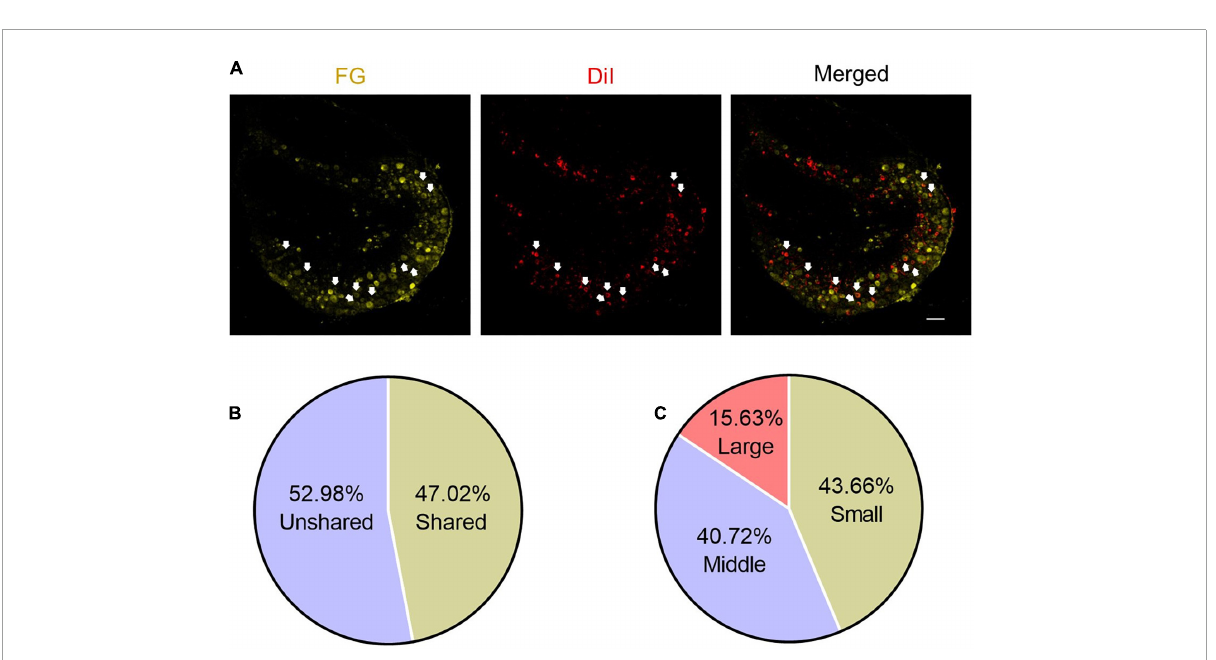
FIGURE2 Some DRG neurons innervate both ST36 acupoint and ipsilateral hind paw plantar. (A) The representative pictures of shared DRG neurons. FG, Fluoro-Gold. The white arrows indicate double-labeled DRG neurons. Bar = 100 µ m. (B) The percentage of shared neurons in all DRG neurons. (C) The percentages of neurons with different diameters in shared